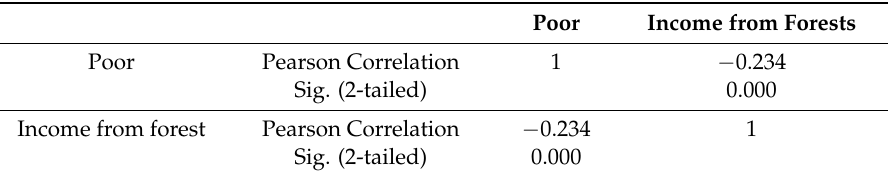
Table 8. Correlation between income from forest products and household type, Con Cuong District, Nghe An Province, 2016.